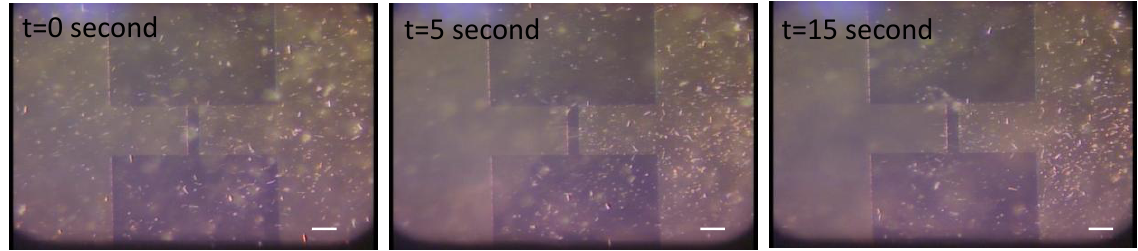
Figure 2. Electrophoretic deposition of Si nanowires; sequential images under a DC potential of 1.5 V. The scale bar is 100